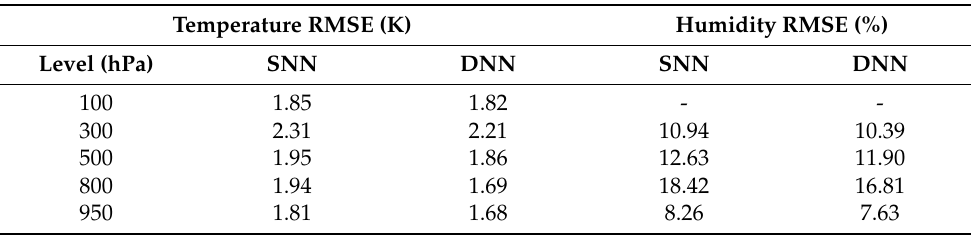
Figure 10. The retrieval RMSEs of the NN-based retrievals using the observations with respect to ERA-Interim. Table 5. Summary of the retrieval RMSE of the NN-based retrievals using the observations with respect to ERA-Interim.